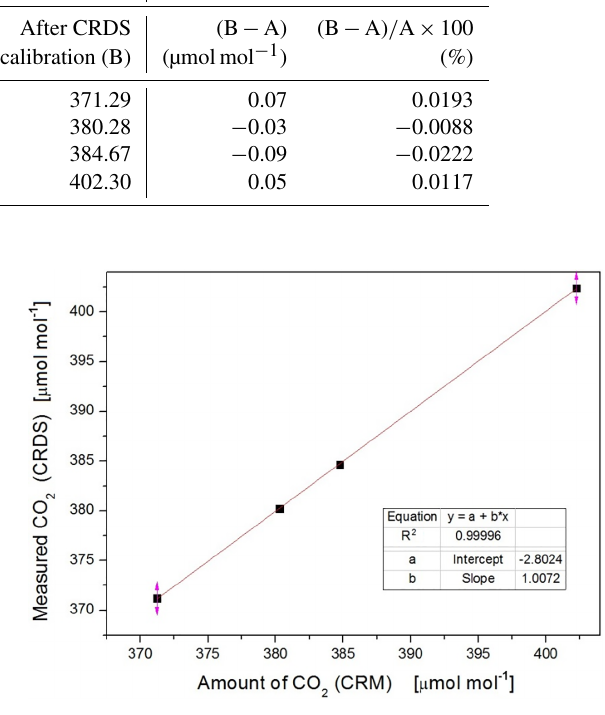
Figure 2. Result of WS-CRDS calibration using gravimetric stan- dards (ambient air background composition, see main text for de- tails). Good agreement between gravimetric and CRDS-determined CO 2 concentrations was